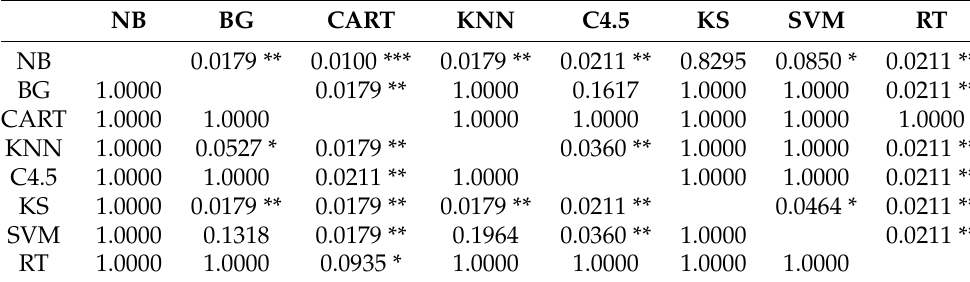
Table 17. Pairwise WSR test for accuracy of adolescents.